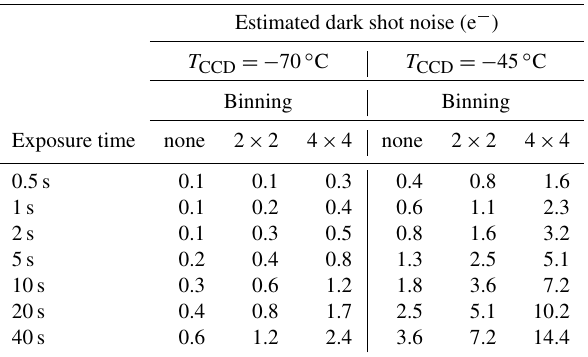
Table A3. Dark shot noise per image pixel estimation depending on exposure time, binning factor and CCD temperature for an average Princeton Instruments ProEM512 camera.